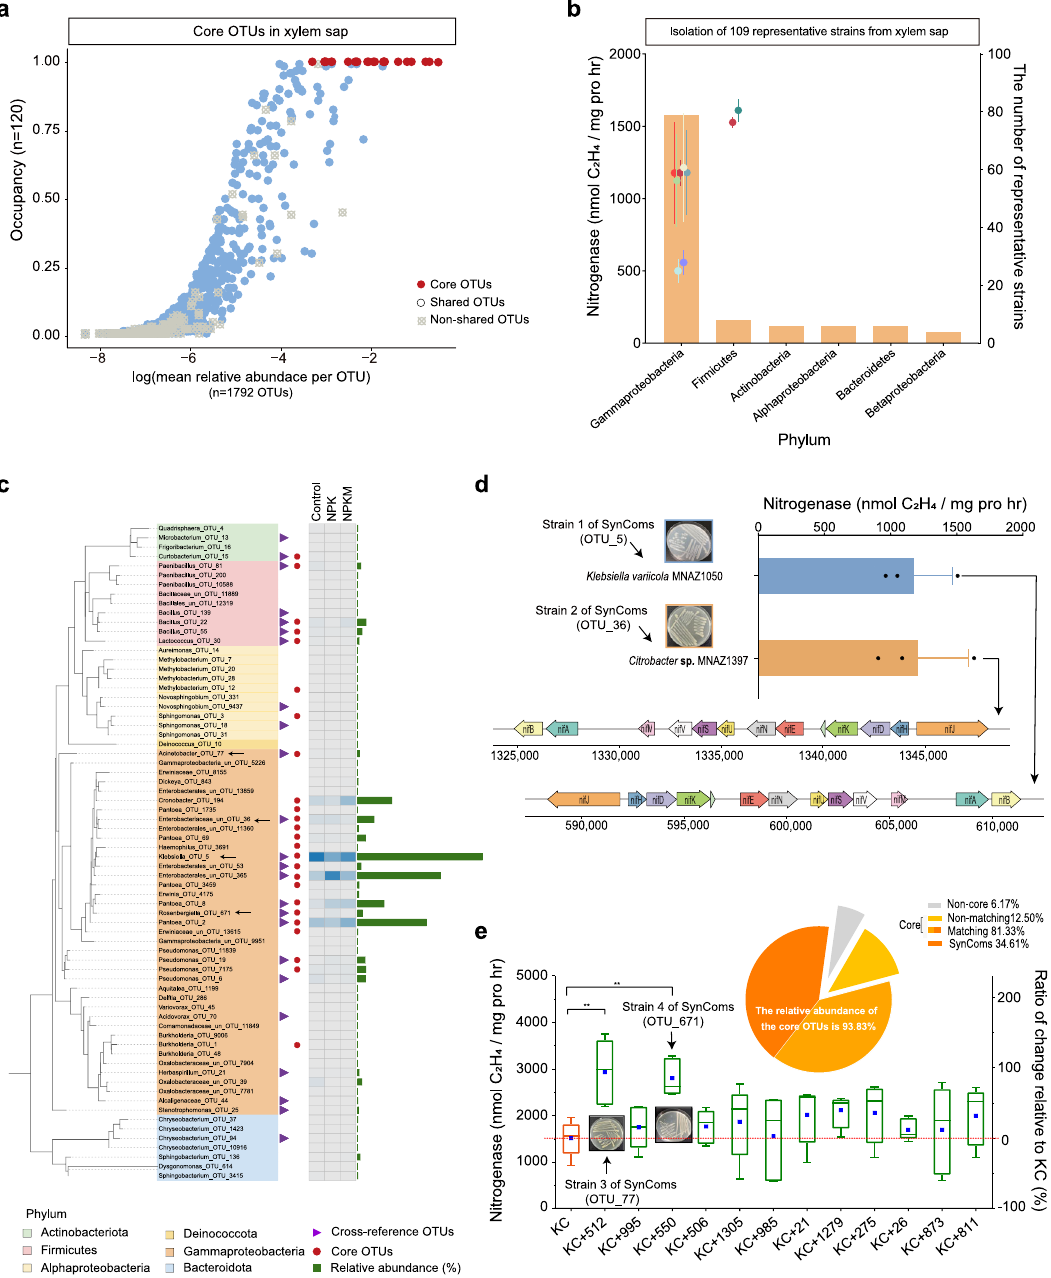
Fig. 4 Identi fi cation and isolation of xylem-inhabiting core bacterial communities. a Occupancy – abundance curves for xylem communities. X-axis displays the log-transformed mean relative abundance of each OTU, y axis displays percentage of samples in which each OTU was detected. OTUs with 1 occupancy are shown in red (core taxa); blue circles represent taxa shared among soil and plant compartments; grey squares indicate non-shared OTUs. b Bar graph depicting number of representative strains at phylum or class level. Points indicate mean nitrogenase activity of diazotrophs at each phylum or class level; error bars indicate standard deviation ( n = 5 for each strain). c Cultivation-dependent coverage of OTUs in xylem. Inner column represents OTUs in xylem with relative abundance >0.01%. Red circles represent core OTUs, which are the same as Fig. 4a. Purple triangles mark OTUs that matched with culturable bacteria. White and blue heatmap represents differences in relative abundance among fertilisation treatments. Green bar graph represents relative abundance of OTUs with a maximum value of 29.2%. d Nitrogenase activity of two core strains (MNAZ1050 and MNAZ1397). The bars indicate mean values and the error bars indicate standard deviation ( n = 3). Arrows mark nif genes with locations shown below arrows. e Nitrogenase activity of 12 combinations relative to KC (KC denotes combination of two diazotrophs, MNAZ1050 and MNAZ1397). Blue rectangles represent the ratio of change relative to KC. Horizontal bars within boxes denote medians. Tops and bottoms of boxes represent 25th and 75th percentiles, and lines extend to 1.5× interquartile range. The statistical analyses were performed using a two-sided T-test ( n = 5). P values are indicated by *, i.e., ** represents P < 0.01. Pie plot shows total relative abundance of each group (core OTUs, noncore OTUs, matching OTUs, non-matching OTUs, SynComs (synthetic communities)). Source data and exact P values are provided in the Source Data fi le.